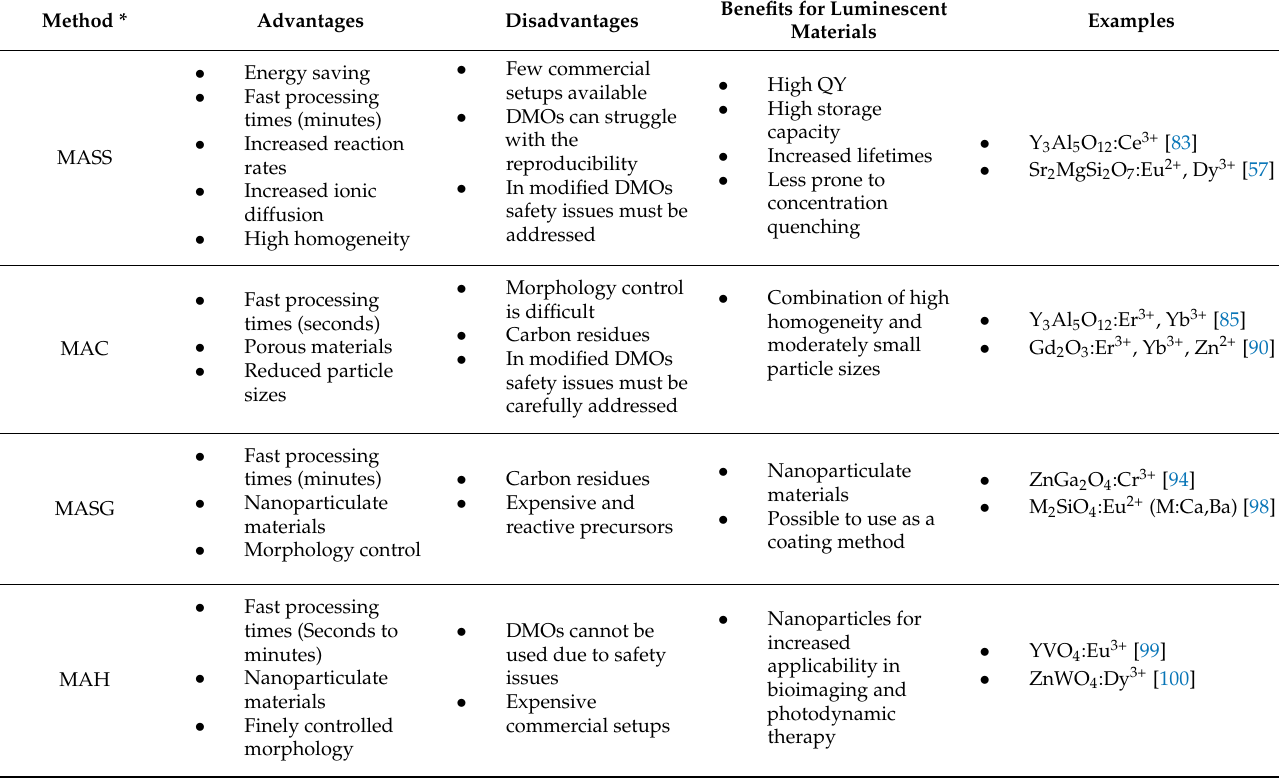
Table 3. Comparison of microwave-assisted methodologies used to obtain luminescent inorganic materials. Method